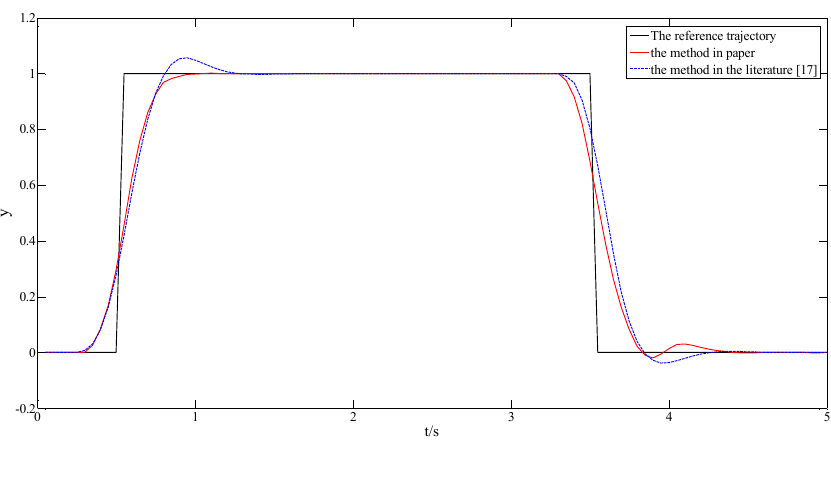
Figure 10. Square-wave tracking